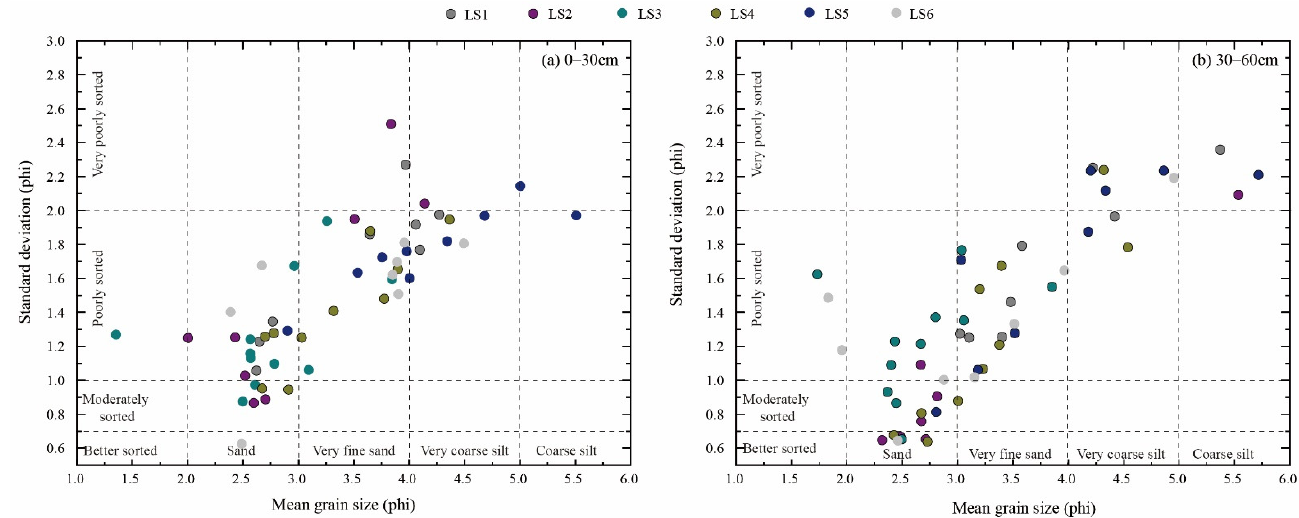
Figure 5. Correlations between mean grain size (Mz) and sorting ( σ I ) of the sediments collected from different landscapes.